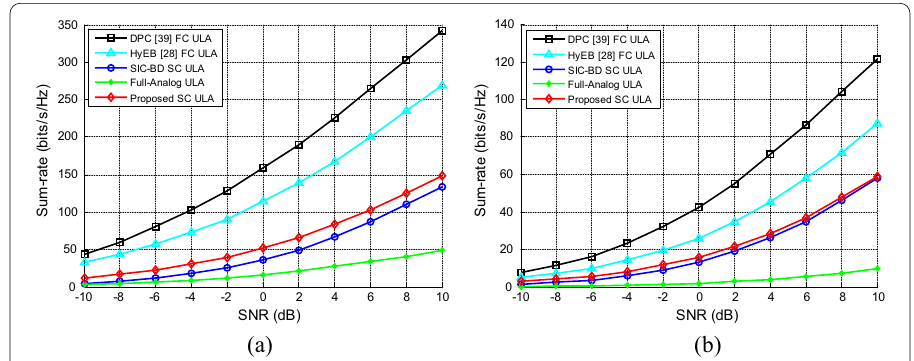
Fig. 3 Sum rate comparison for different beamforming schemes versus SNR in ULA. It illustrates that the different precoding algorithms simulation results when SNR increases from massive MIMO system with N t = 128 is represented by ( a ), and the result under a MIMO system with N t = 32 is represented by ( b